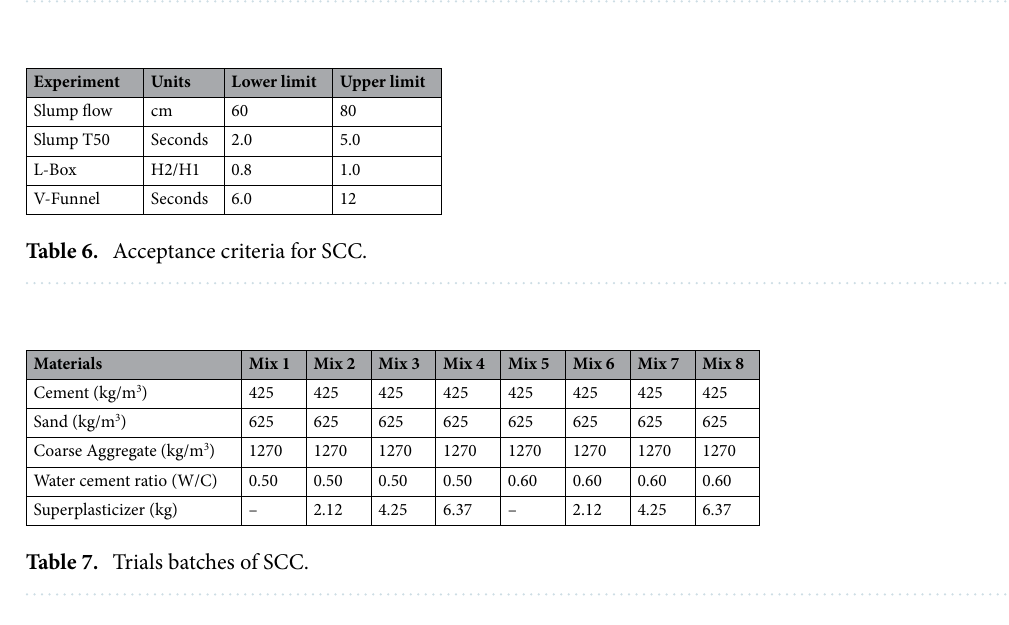
Table 5. Properties high range water reducing admixture.